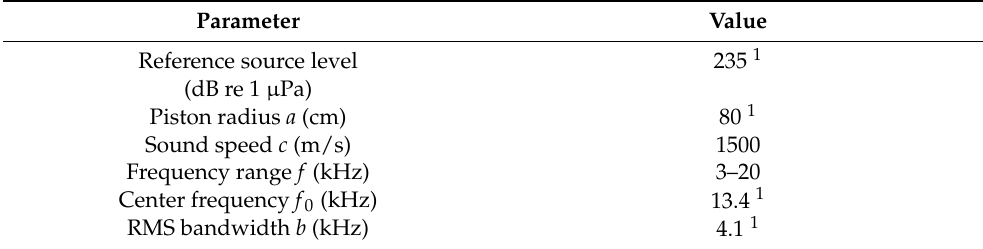
Table 2. Parameters for estimating sperm whale click directivity